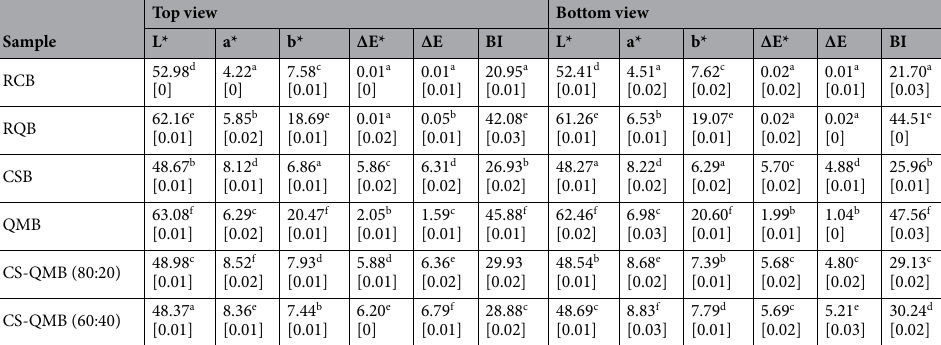
Table 2. Color profile of the raw, cowpea sourdough, quinoa malt whole and multigrain biscuits. Various superscripts presented per column indicate significant differences ( p ≤ 0.05). Values in square brackets are standard deviations of the respective means. L* lightness, a* redness, b* yellowness, ∆E* total color difference for CIELAB coordinates, ∆E total color difference for Hunter LAB coordinates, BI browning index, RCB raw cowpea biscuit, RQB raw quinoa biscuit, CSB cowpea sourdough biscuit, QMB quinoa malt biscuit, CS-QMB (80:20) 80% cowpea sourdough and 20% quinoa malt biscuit, CS-QMB (60:40) 60% cowpea sourdough and 40% quinoa malt biscuit.